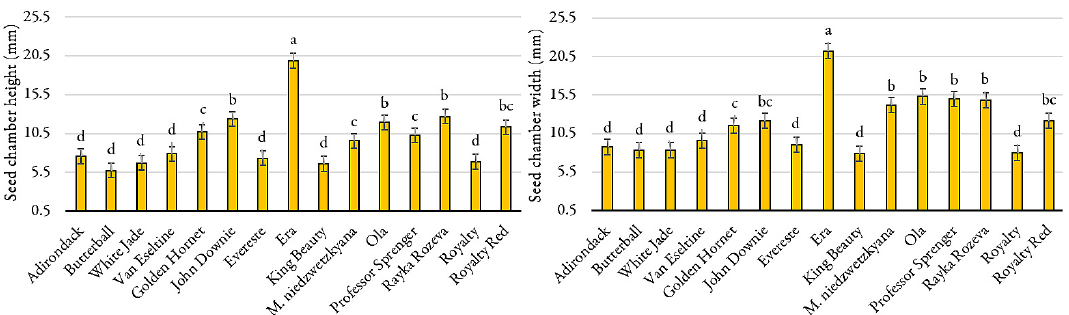
Figure 4. The main characteristics of the seed chamber of fruit in the 15 cultivars of ornamental crabapples